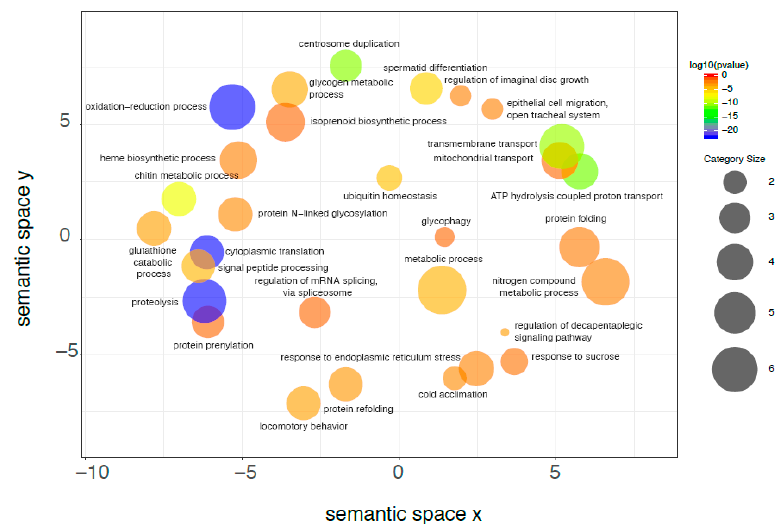
Figure 7. Upregulated genes associated to the GO category “Biological Processes”. Starting from the enrichment analysis of genes that are upregulated in midguts of larvae reared on VMD compared to SD, REVIGO was used to group similar biological processes on the basis of the SimRel semantic similarity metric; in this way, categories with similar descriptions are close in the plot. As shown in the scale on the right, the color of the bubble identifying each biological process is a function of log 10 ( p value) for the false discovery rate for the enrichment of each process. Bubble size indicates the frequency of each GO term (larger size indicates larger categories) and was calculated by REVIGO on the basis of the size of each category in a background database (SwissProt [42]). Only categories with FDR ≤ 1.0 × 10 − 3 were selected, see full list in Supplementary Tables S3–S7.